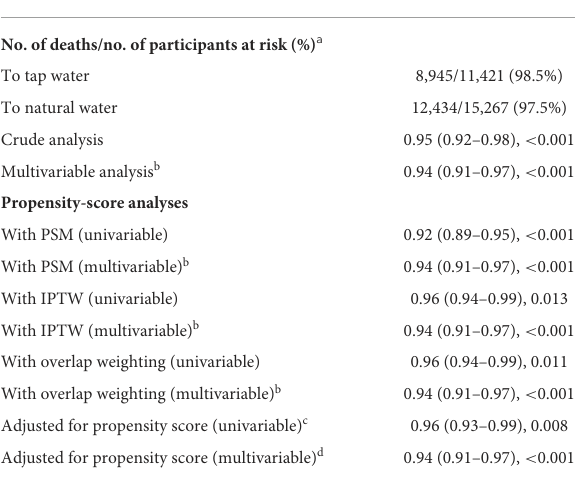
TABLE 3 Associations between drinking natural water and all-cause mortality (natural water vs. tap